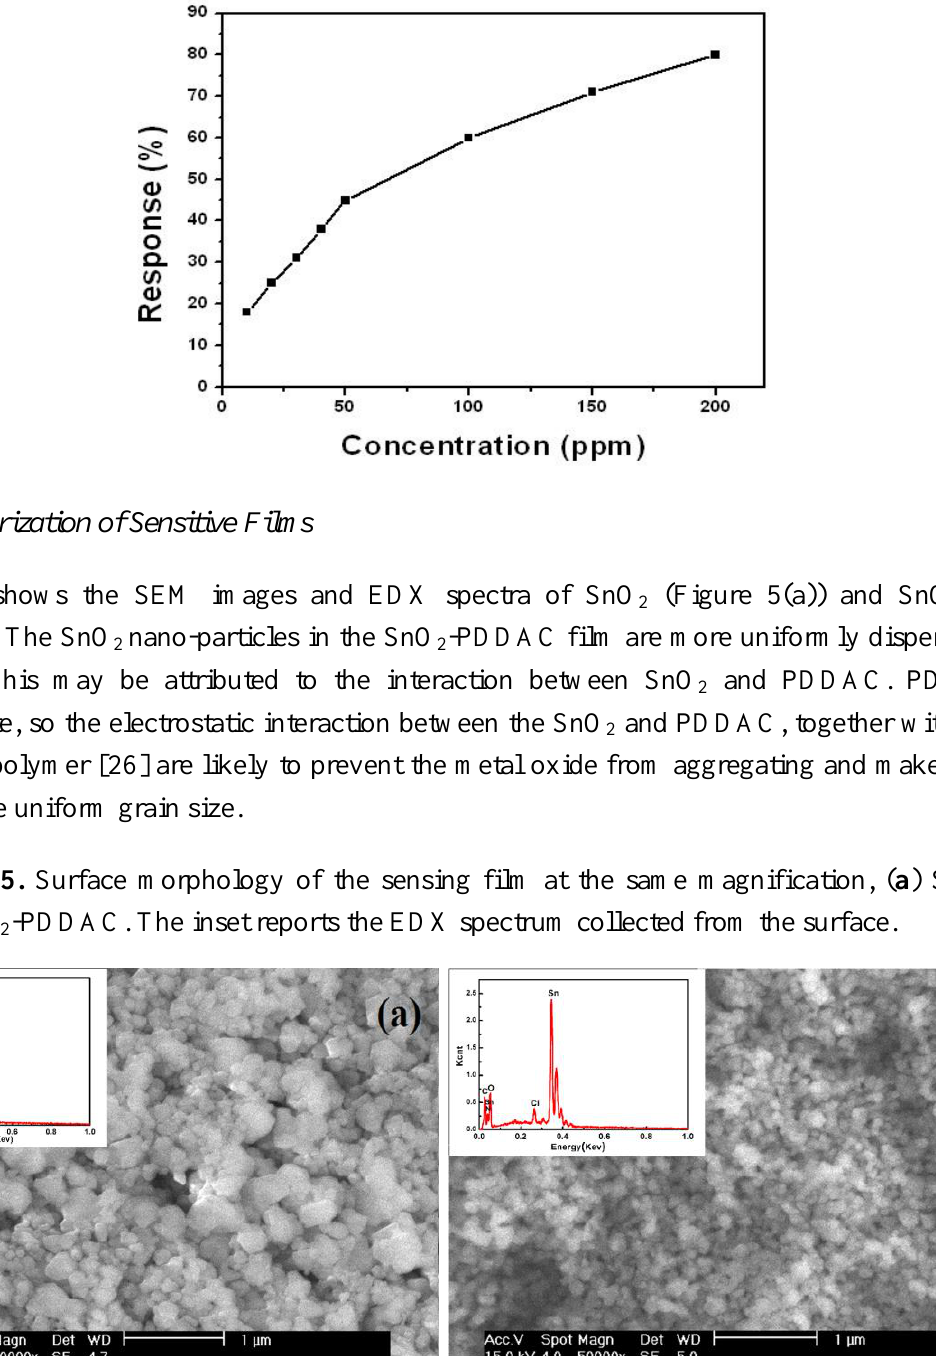
-PDDAC sensor to ethanol of different 2